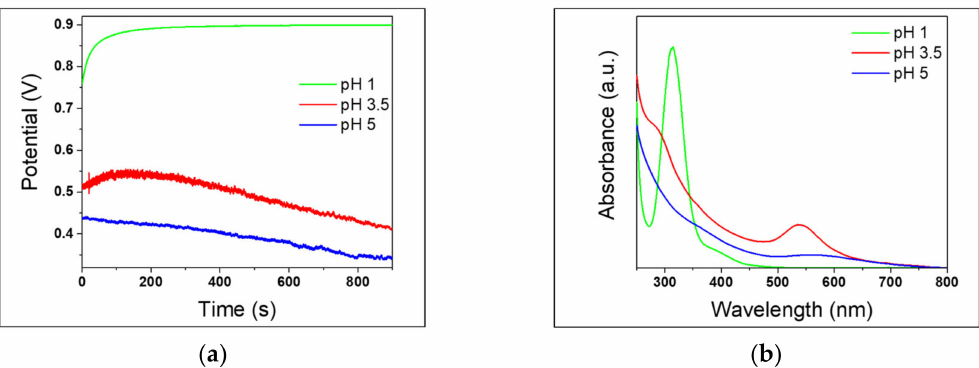
Figure 10. 430-AuNPs synthesis carried out at di ff erent pH. ( a ) OCP measurements; ( b ) UV-Vis